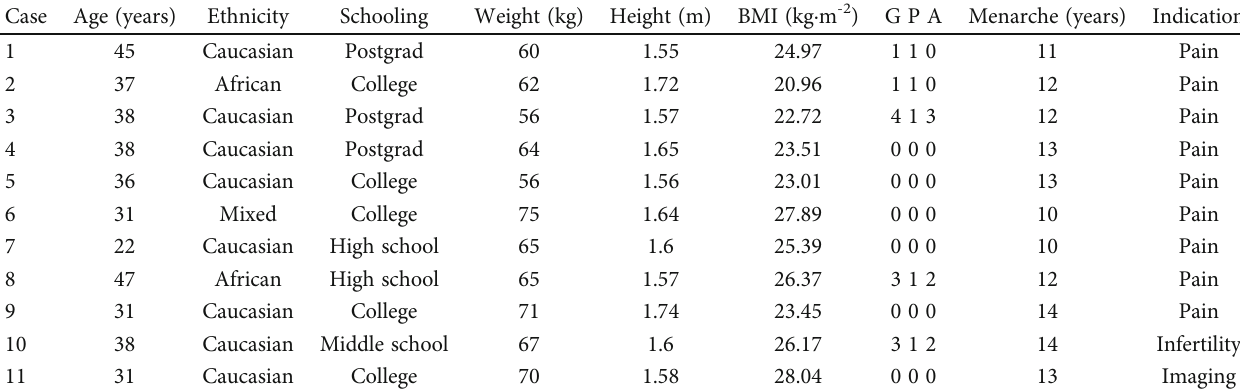
Table 1: Anthropometric characteristics, obstetric histories, and indication for each surgery.